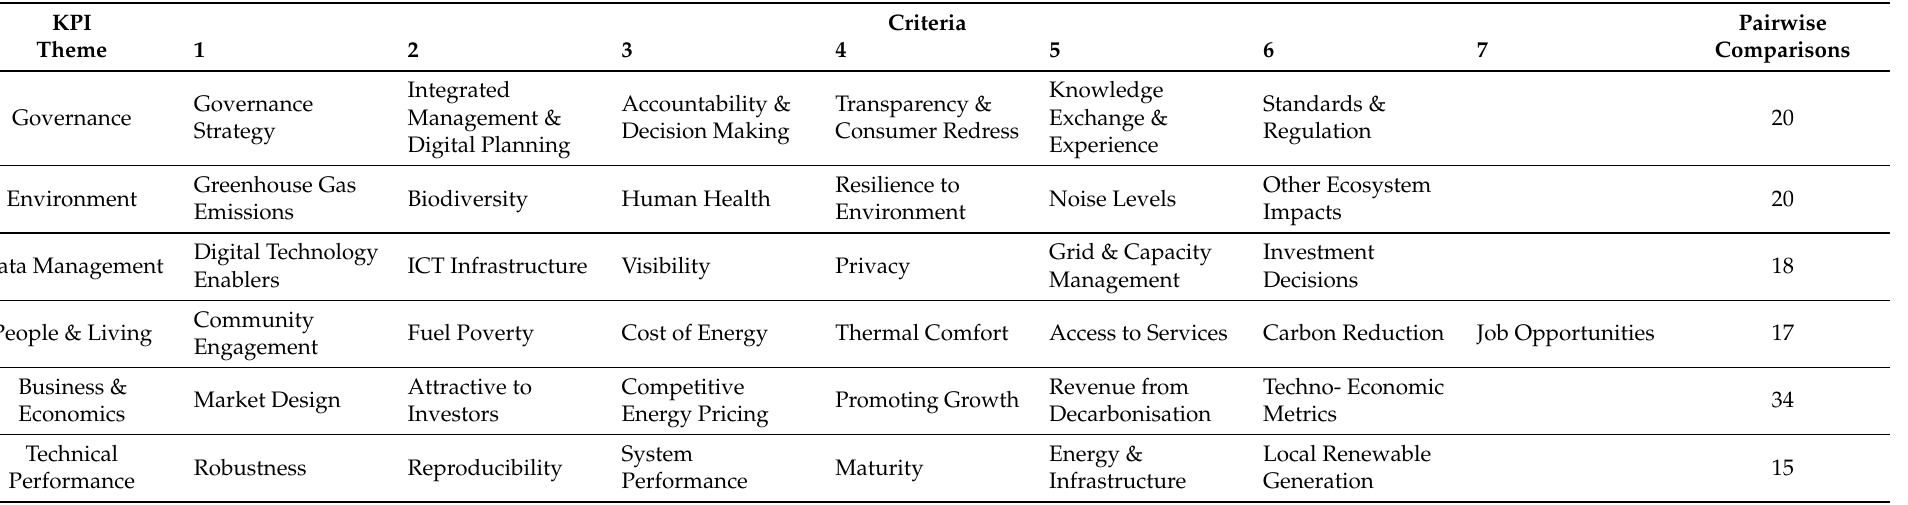
Table 1. Theme-specific criteria (indicators, success criteria or metrics) for the six optional thematic surveys together with the typical number of pairwise comparisons presented to the